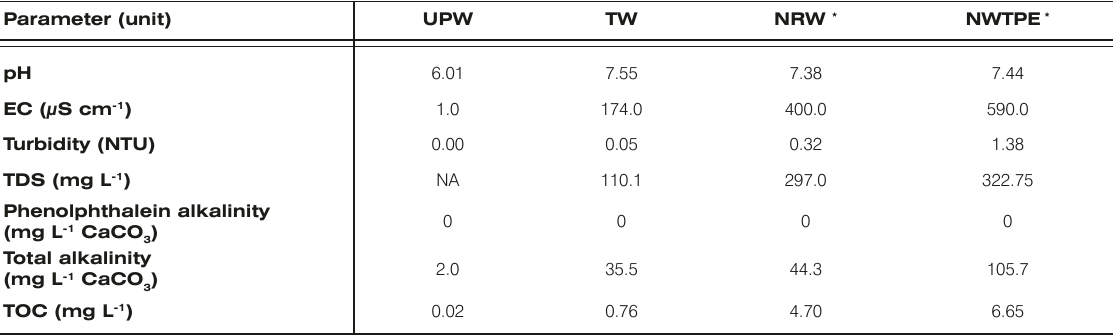
Table 3. Characteristics of tested water